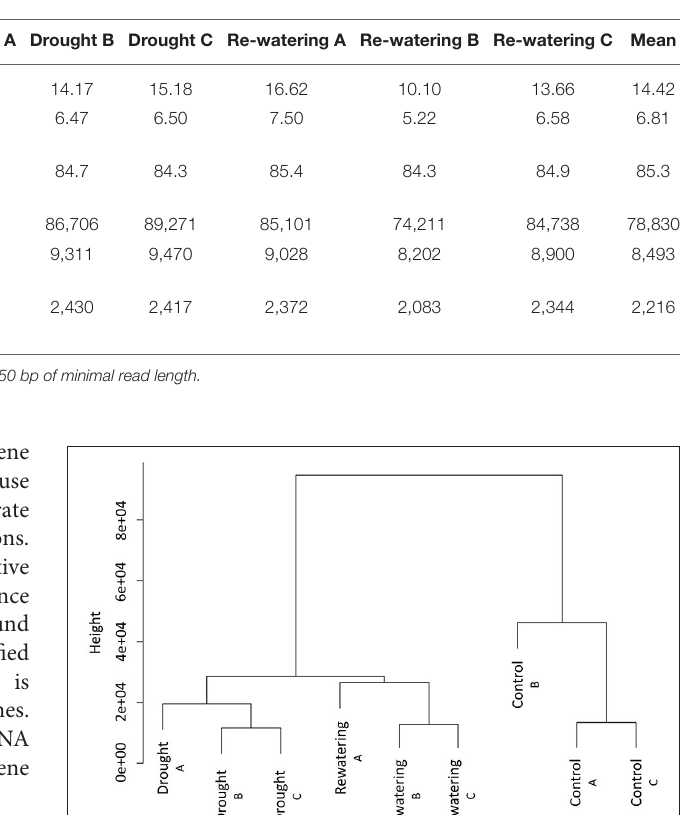
TABLE 2 | The statistics of MSAP-Seq reads during different data processing steps during evaluation of changes in barley methylome in leaves under water-deficiency stress.